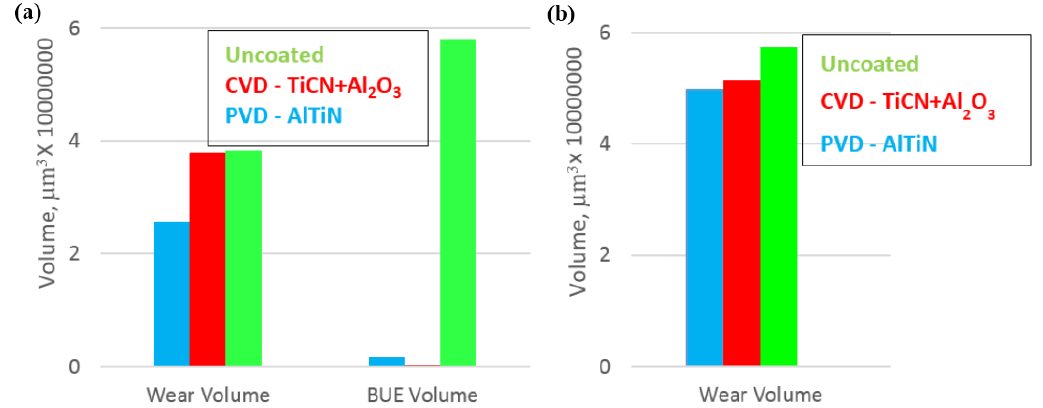
Figure 6. Comparison of total wear volume and BUE volume for uncoated and coated tools ( a ) before, and ( b ) after etching.